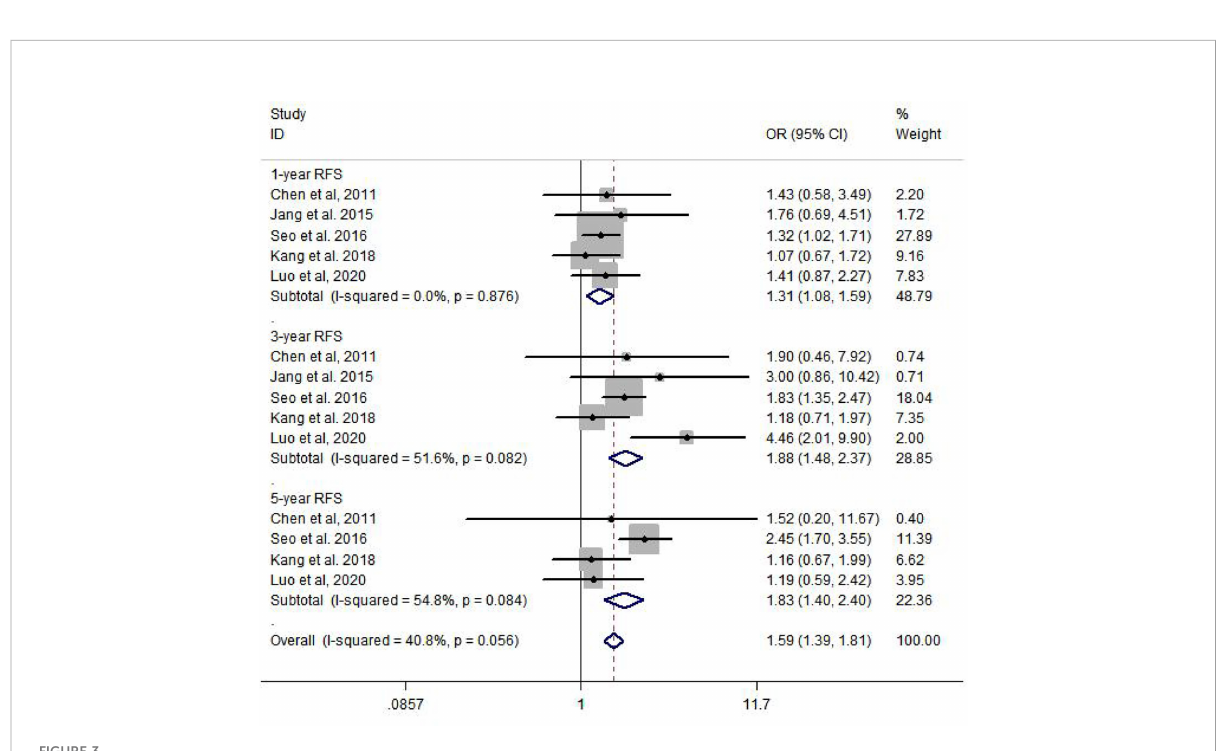
FIGURE 3 Meta-analysis of